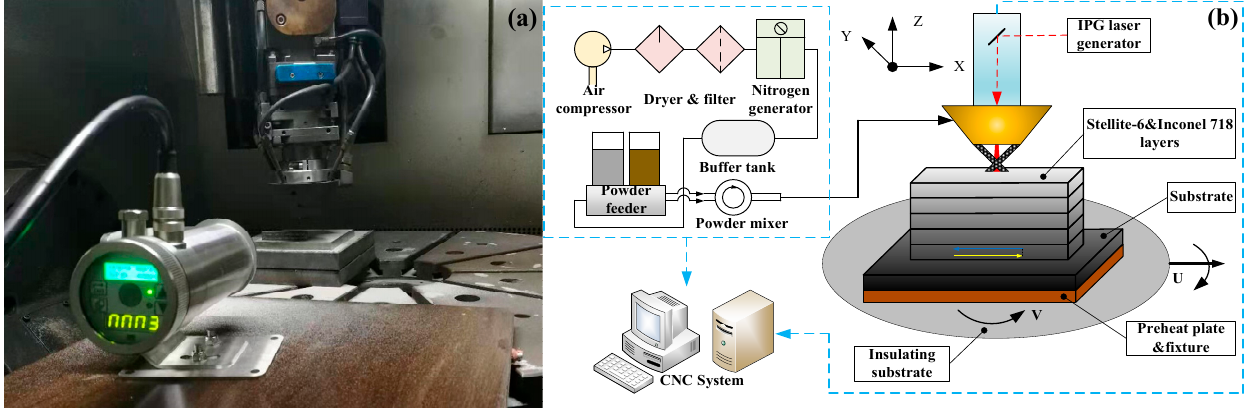
Figure 2. ( a ) SVW80C-3D hybrid additive and subtractive machine center; ( b ) principle of LMD process for Stellite-6/Inconel 718 FGM.